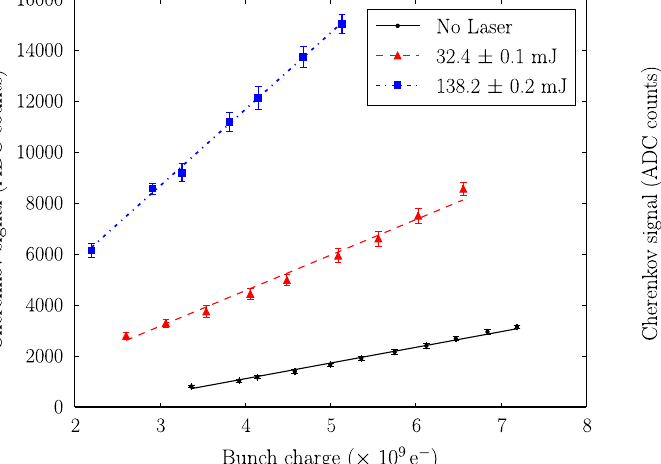
FIG. 17. Variation of the Cherenkov signal with laser pulse energy for various electron bunch